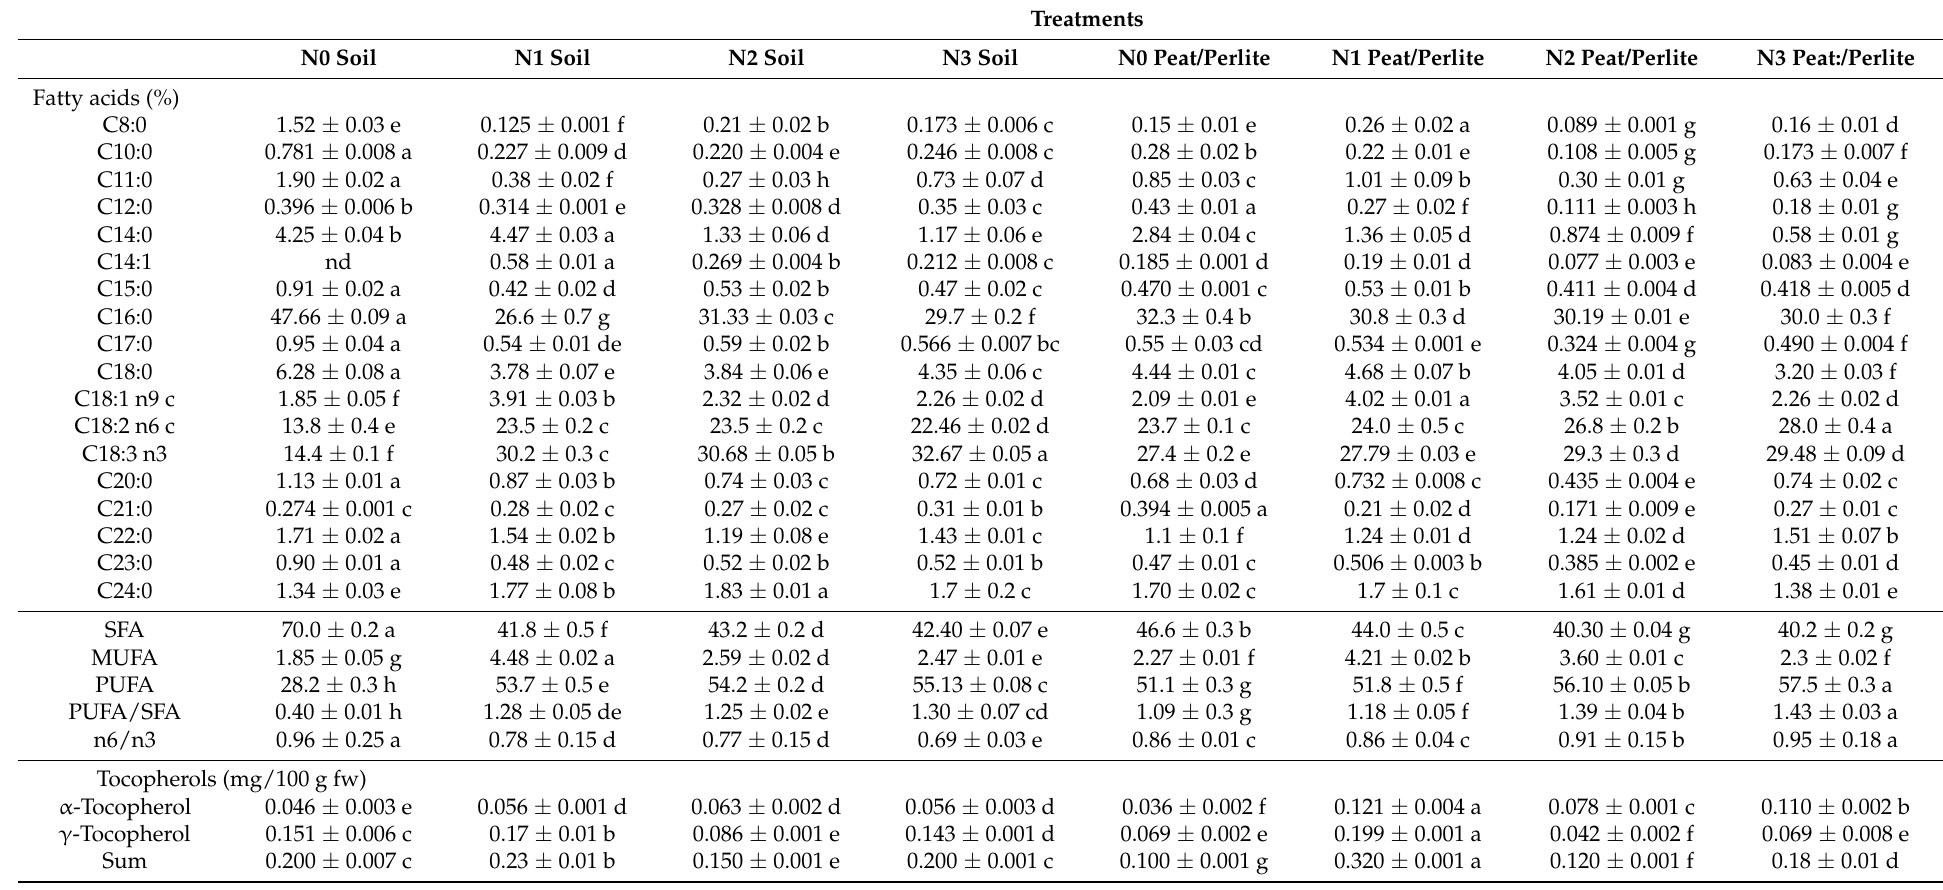
Table 2. Chemical composition with regard to lipophilic compounds of the studied Centaurea raphanina (%) (mean ± SD).